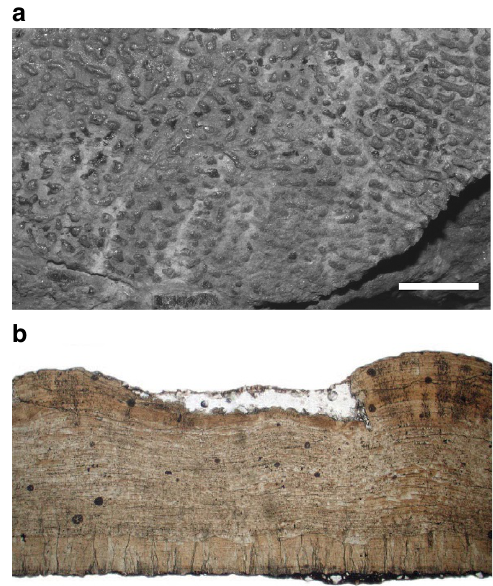
Figure 4 | Eggshell associated with Beibeilong sinensis (HGM 41HIII1219). ( a ) Photograph showing the ornamentation on the outer surface of Macroelongatoolithus eggshell. Scale bar, 2cm. ( b ) Photomicrograph showing histological section of Macroelongatoolithus eggshell in radial view shows two microstructural layers (lower mammillary layer and upper continuous layer) demarcated by an undulatory boundary (arrow). Scale bar is